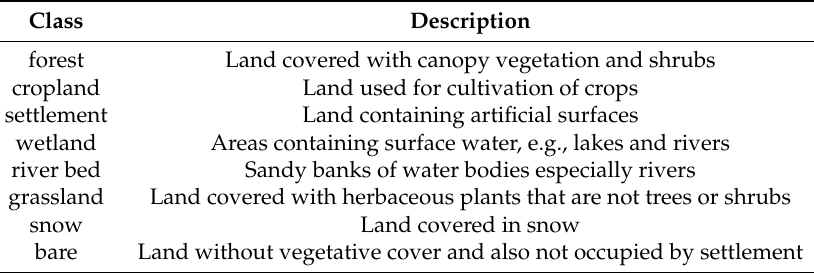
Table 1. Typology of the land cover classes used for the